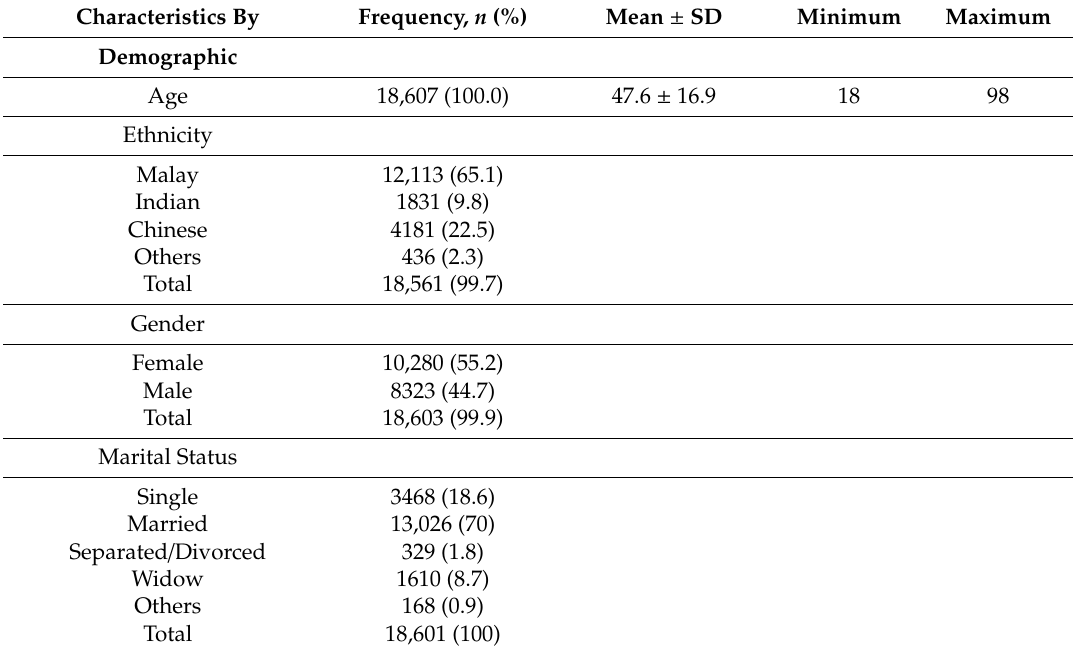
Table 1. Sample characteristics of rural communities ( n =